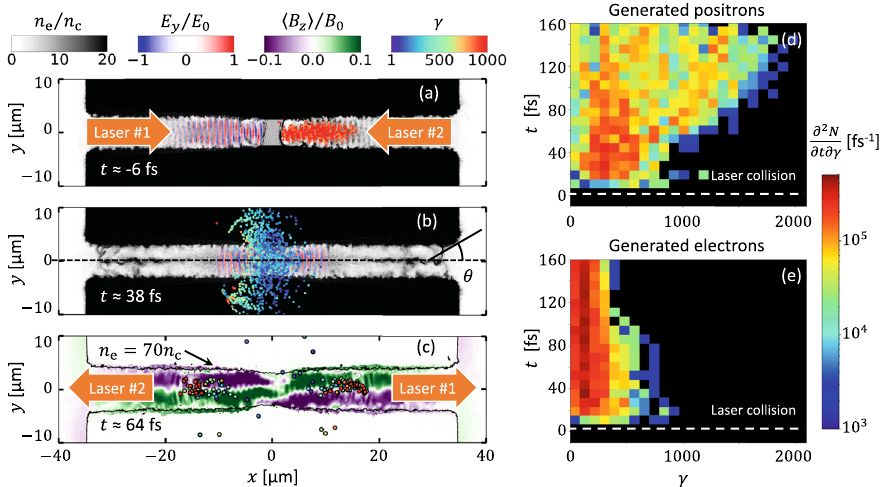
Fig. 1 Positron production and acceleration in a structured plasma target. Results from a 2D-3V particle-in-cell (PIC) simulation of two laser pulses with a = 190 irradiating a structured plasma target. a Electron density n fi eld of laser #1 E y (color scale) and energetic 0 e (gray scale), transverse electric electrons with γ ≥ 800 accelerated by laser #2 (dots, colored by γ ). b Total transverse electric fi eld E y (color scale) and electrons from panel ( a ). c Laser- accelerated positrons (points), con fi ned by the quasistatic plasma magnetic fi eld 〈 B z 〉 (color scale). E 0 and B 0 are the peak laser electric and magnetic fi elds in vacuum. Time evolution of the energy spectra of d positrons and e electrons generated by nonlinear Breit – Wheeler pair creation: the horizontal, dashed lines indicates the time at which the lasers collide.